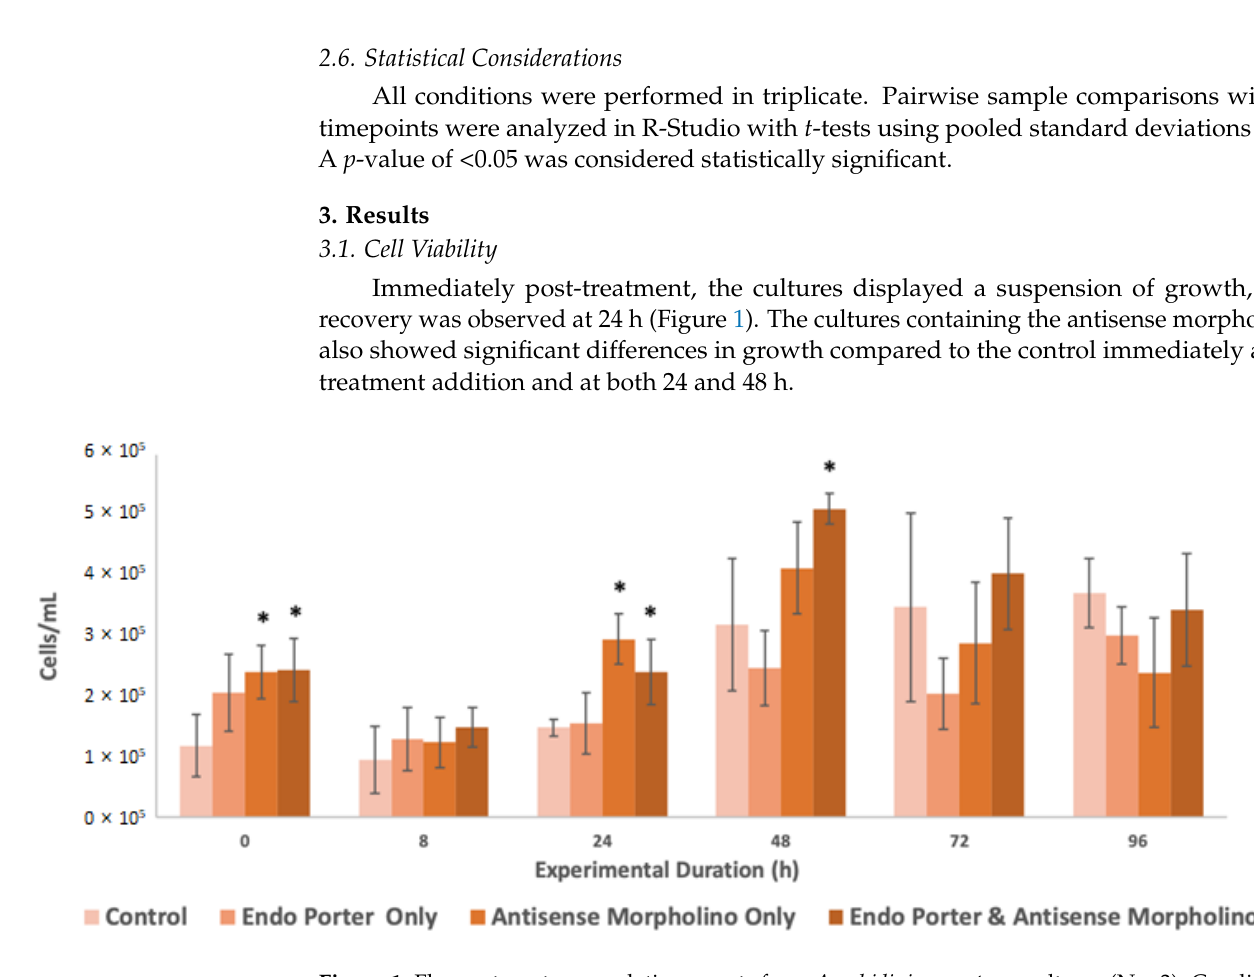
Figure 1. Flow cytometer population counts from Amphidinium carterae cultures (N = 3). Conditions included the control, Endo-Porter only, antisense morpholino only, and the Endo-Porter and antisense morpholino combined. Statistical analysis was done using t -tests with pooled standard deviations. * Significantly different from ‘Control’ based on a p -value of < 0.05.